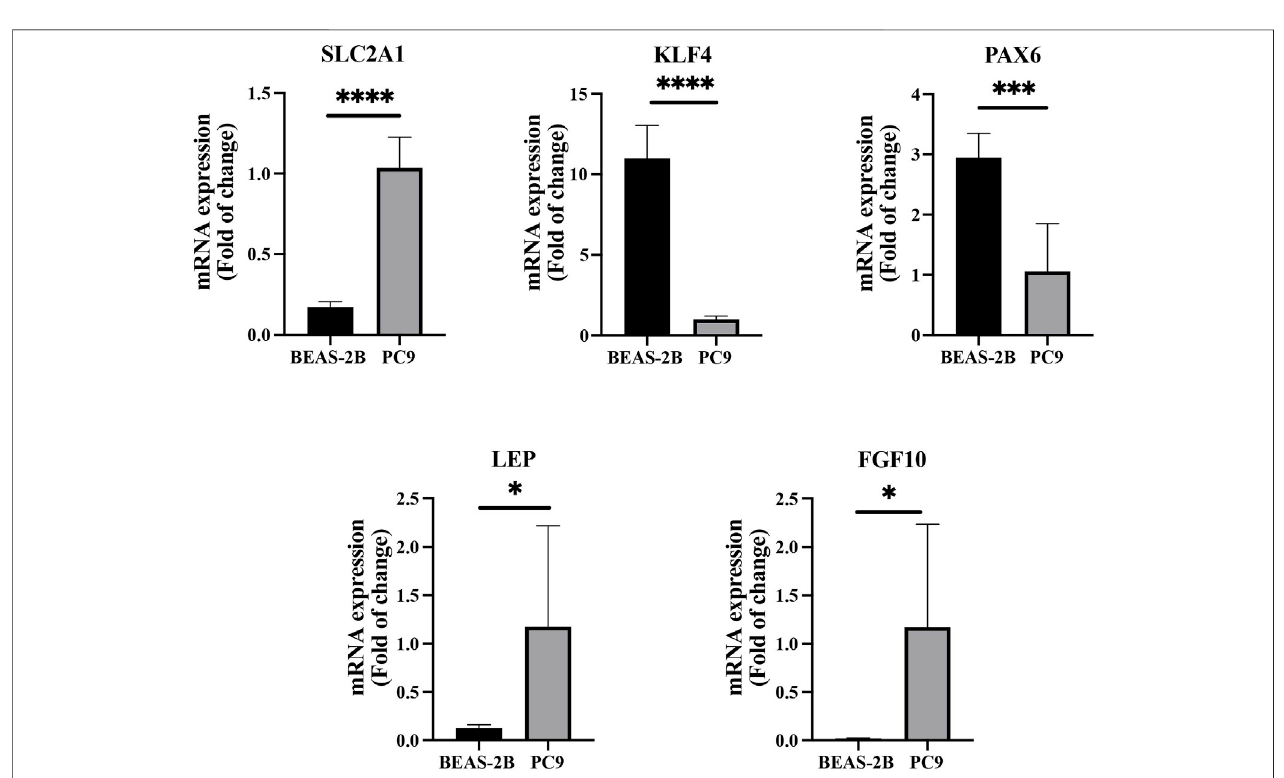
Frontiers in Genetics |